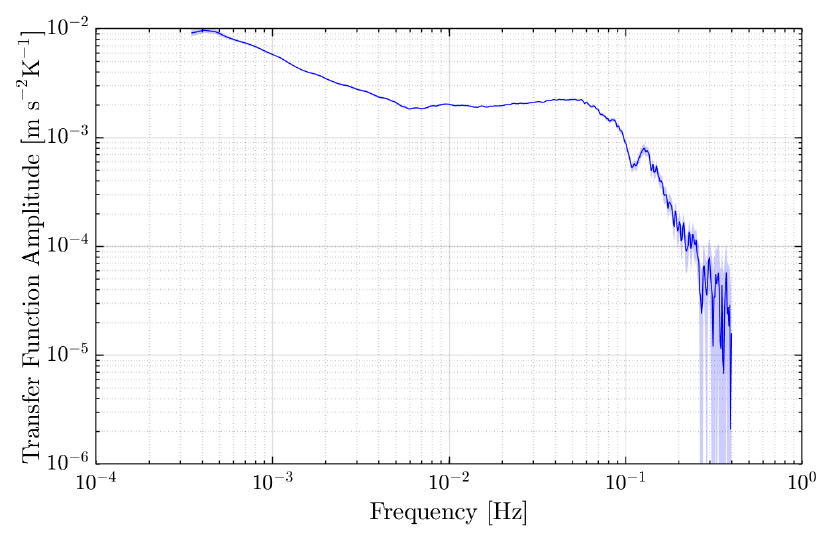
Figure 9. The transfer function between vacuum chamber temperature and acceleration. Note that between 300µHz and 50mHz, the amplitude varies by a factor of nearly 5, suggesting that a linear regression would not be suitable for this data set. The transfer function is not plotted below 300µHz because the low number of averages causes large uncertainties. The shaded area represents the estimated error bars of the